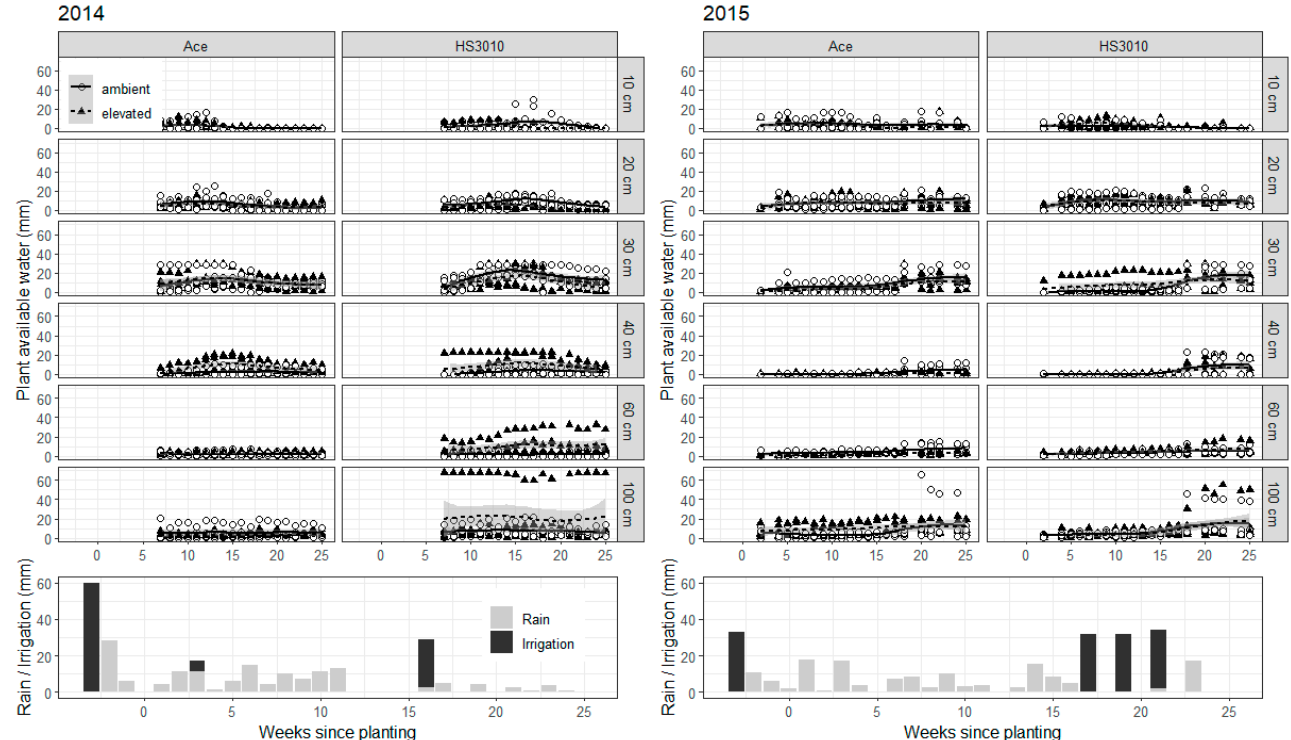
Figure 2. Plant available water for lentil by [CO 2 ] and depth in the Australian Grains Free Air CO 2 Enrichment in 2014–2015 with rainfall and irrigation events during the season. In both years, a [CO 2 ] by cultivar by time by depth interaction was significant in 2015. Planting occurred at week 0, flowering at week 17, and harvest at week 25 in both years. Round white circles represent individual sub-plots in ambient main plot, and black triangles individual sub-plots in elevated [CO 2 ] main plots. Grayed areas are the calculated confidence interval for treatment means as calculated by the ggplot2 R package. Symbols may be drawn on top of one another.